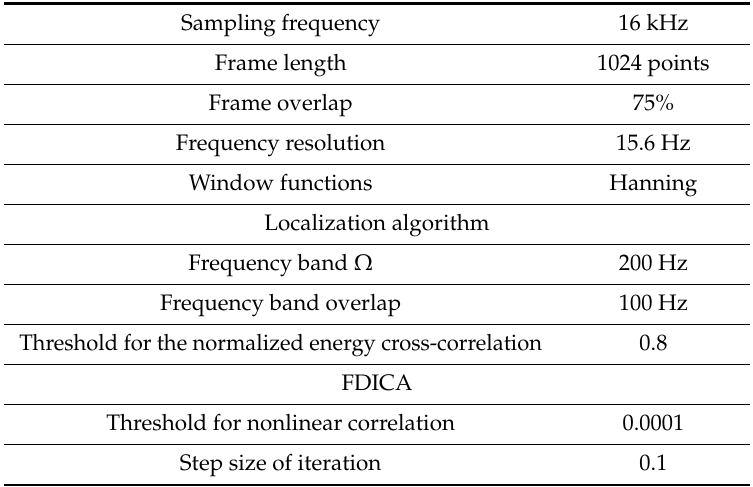
Table 1. Configurations for proposed method.